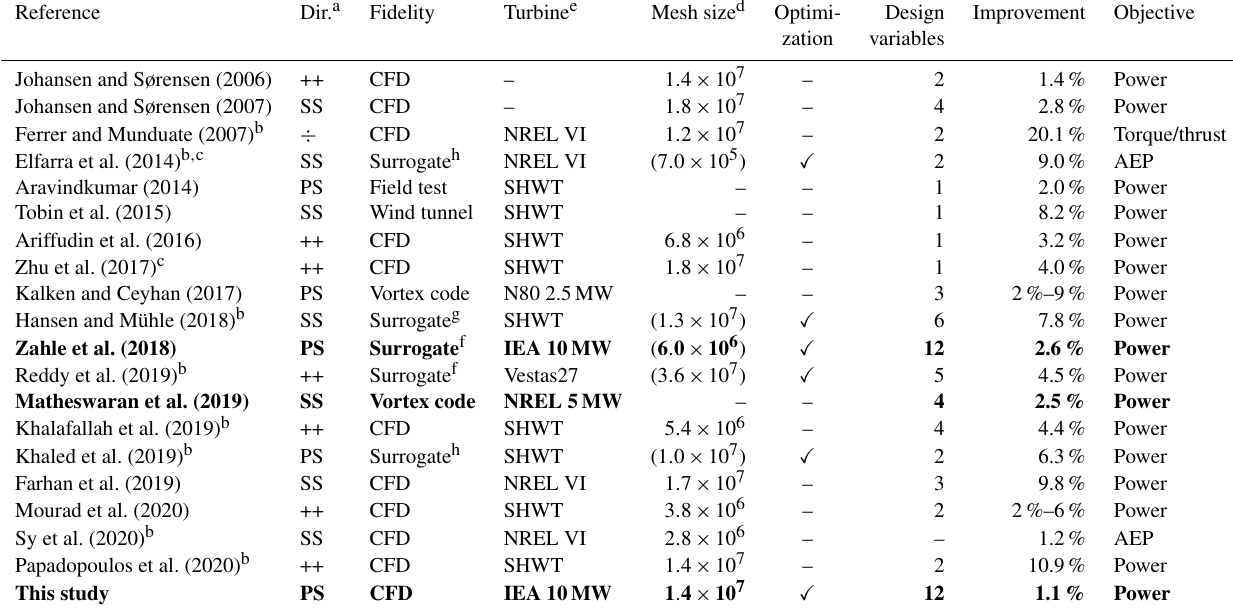
Table 1. Overview of the tip and winglet studies most relevant to the present work. Bold rows signify a reported load-neutral final design. In the case of a sequence of studies by the same author(s) a representative study was chosen. For works including both a simple straight blade extension and an actually novel tip device including a flapwise displacement, it is the latter that has been included